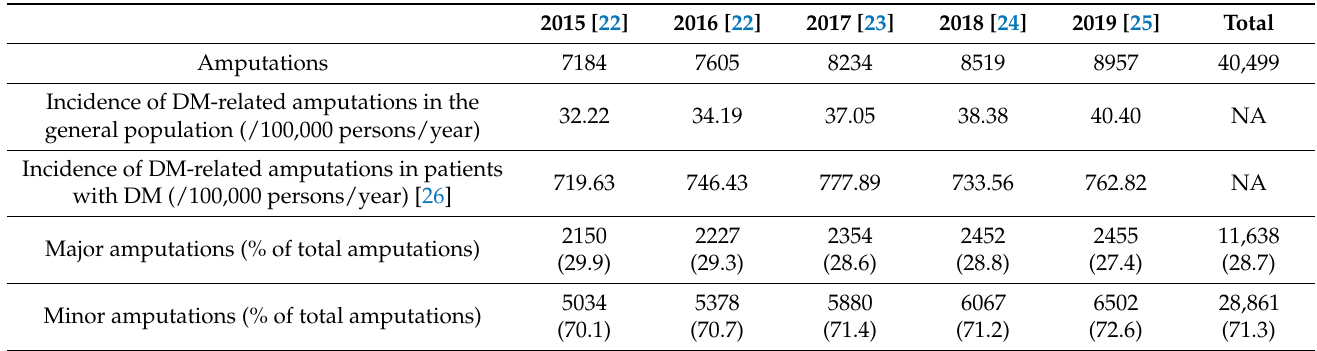
Table 1. Absolute number, crude incidence and level of amputations by